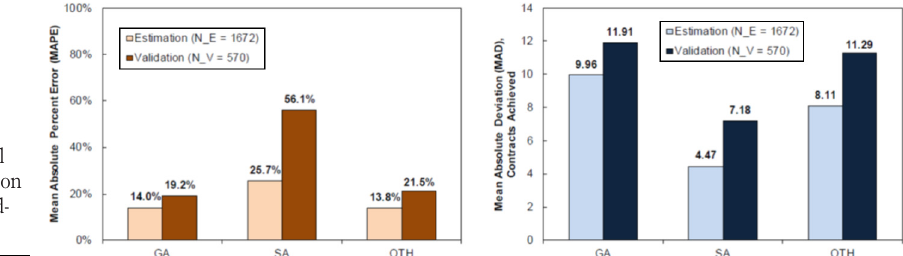
Figure 5. Summary of model validation metrics on the model and hold- out data